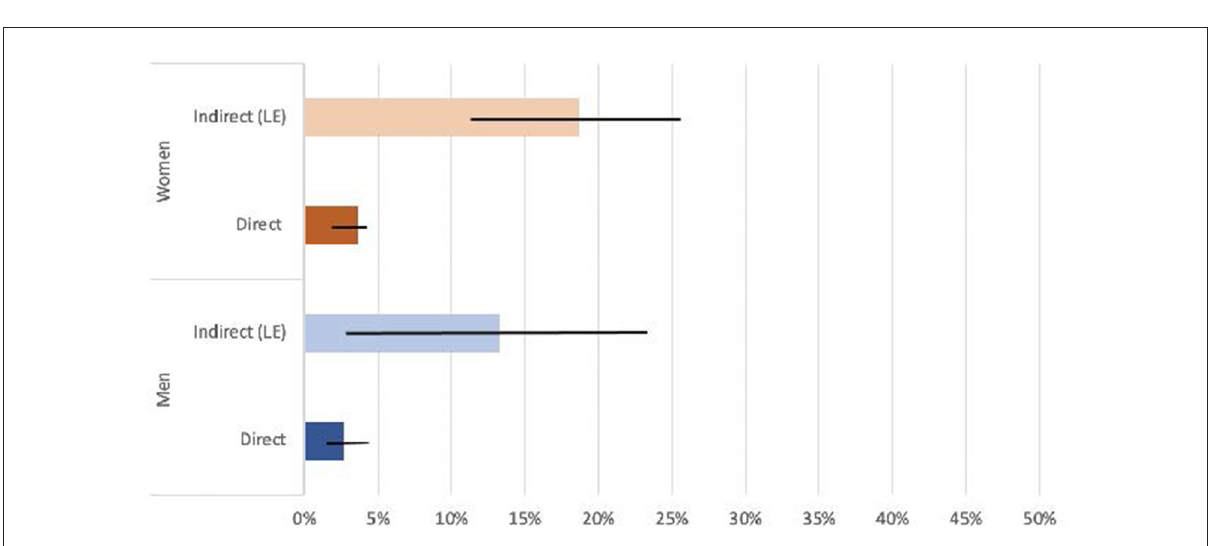
FIGURE2 Direct and indirect (List Experiment) sexual IPV disclosure, stratified by